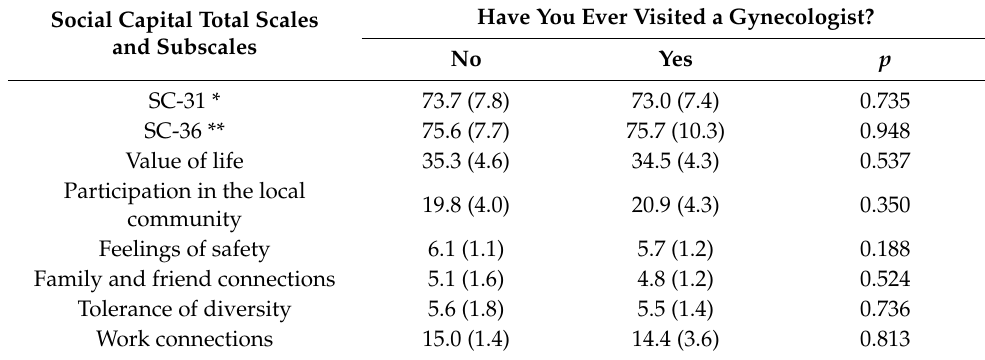
Table 6. Social capital scores (means, SDs) and use of a gynecologist.